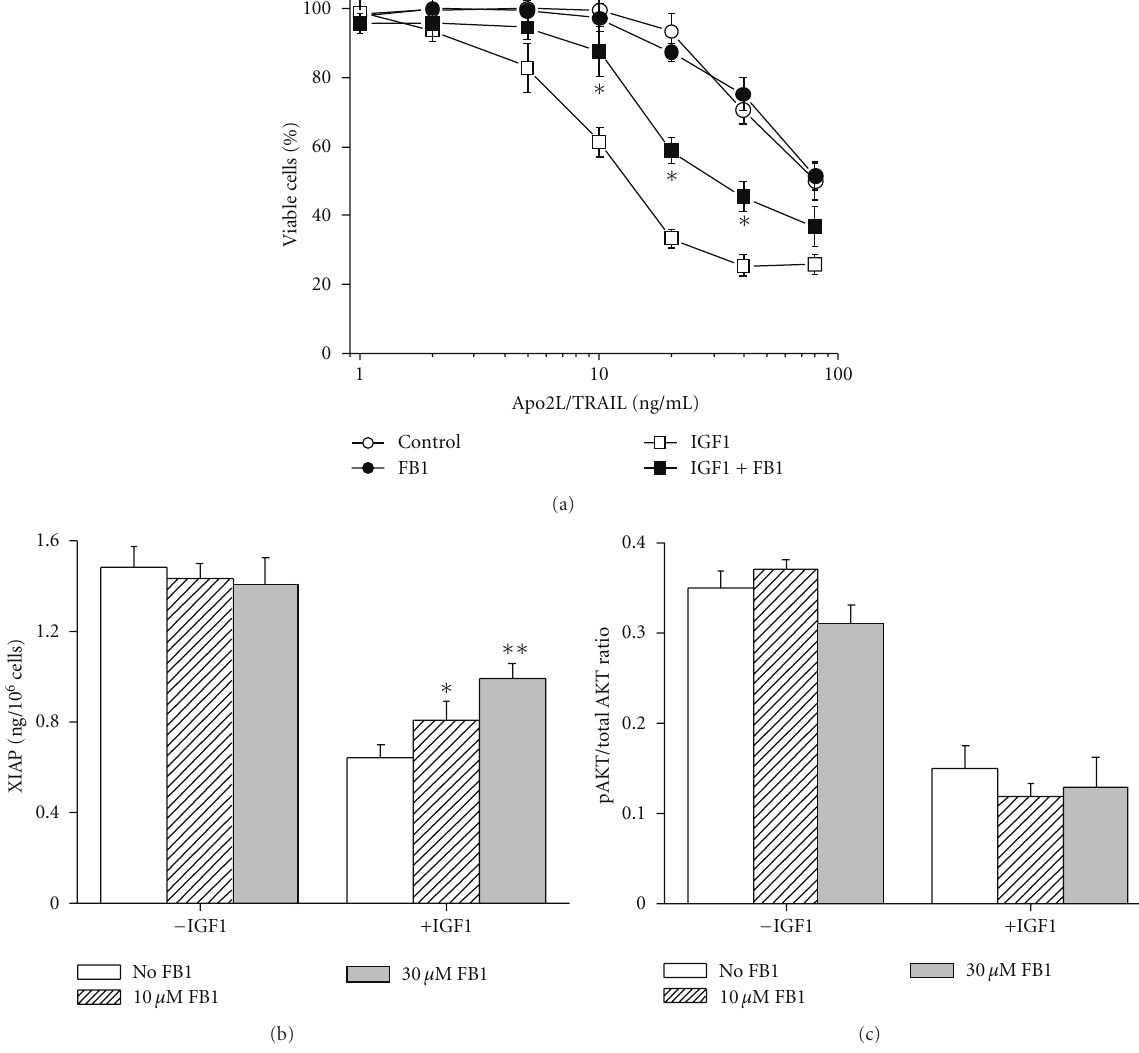
Figure 7: Functional consequences of Cer formation. (a) Percentage of viable VH-64 cells treated for 72 hours without ( ◦ , • ) and with ( (cid:2) , (cid:3) ) IGF1 (100 ng/mL) in the absence (open symbols) and presence (closed symbols) of FB1 (30 μ M), followed by incubation for 18 hours with the indicated concentrations of Apo2L/TRAIL. (b) EIA analysis of XIAP in VH-64 cells treated for 72 hours without and with IGF1 (100ng/mL), in the presence of the indicated concentrations of FB1. (c) Ratio of phosphorylated AKT to total AKT determined by ELISA in VH-64 cells treated for 72 hours without and with IGF1 (100 ng/mL) in presence of the indicated concentrations of FB1. Asterisks: ∗ P < 0 . 05, ∗∗ P < 0 . 02; error bars: mean ± SD of quadruplicate determinations from 3 independent